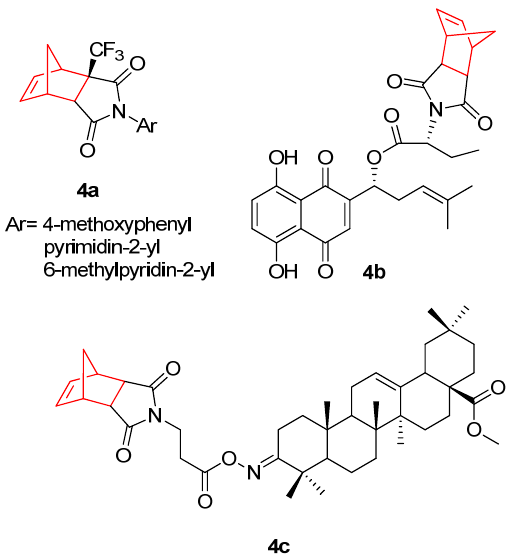
Figure 4. Different norbornene ‐ containing molecules with antitumor effects